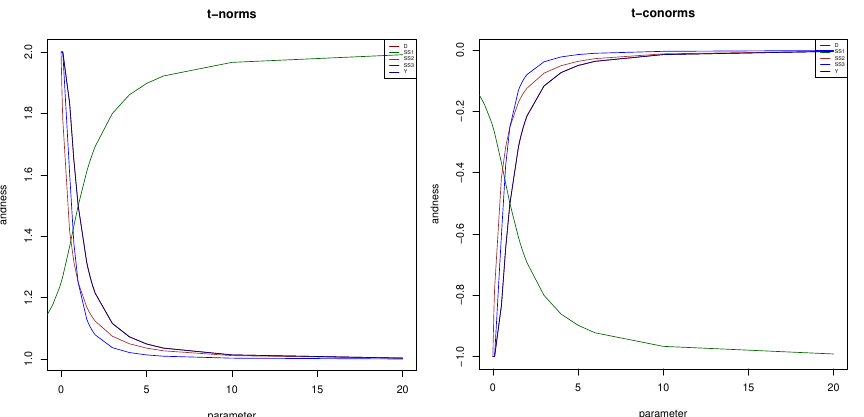
Figure 1. Andness of t-norms T D , T SS 1 , T SS 2 , T SS 3 , T Y ( left ) and t-conorms S D , S SS 1 , S SS 2 , S SS 3 , S Y ( right ) in terms of their parameters ( λ , p , or w ).